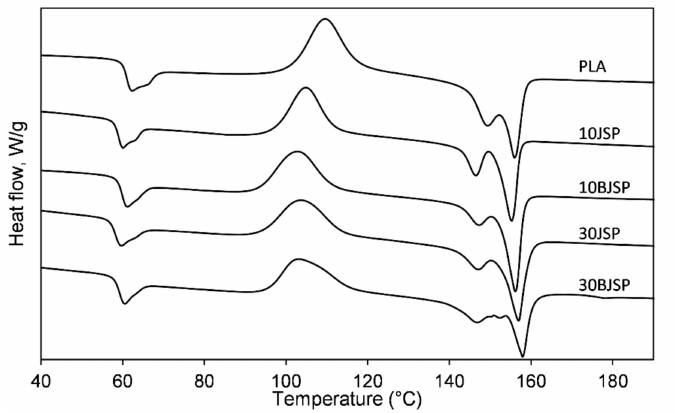
Figure 7. Di ff erential scanning calorimetry (DSC) analysis for PLA and its thymol composites.